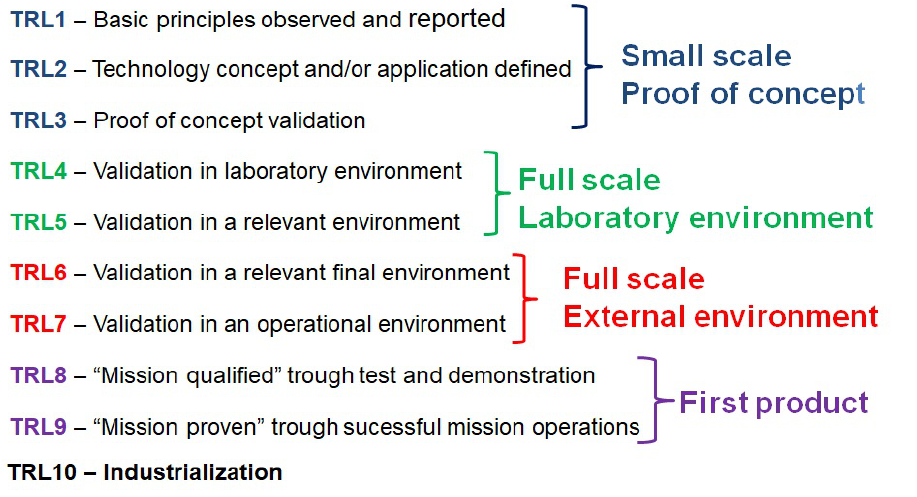
Figure 10. The TRL scale, proposed by NASA with the inclusion of a 10th